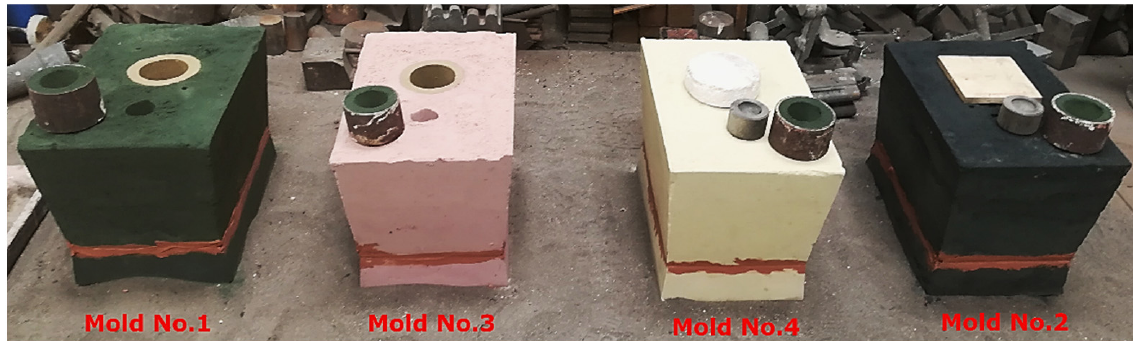
Figure 2. Molds used for experimental castings.